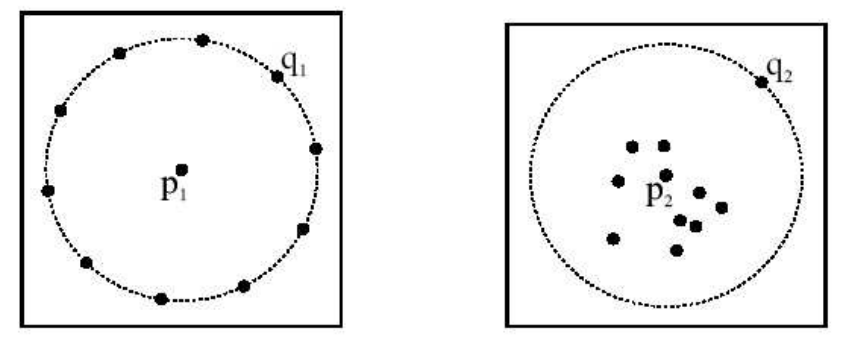
Figure 1. Points with the same D k value but different